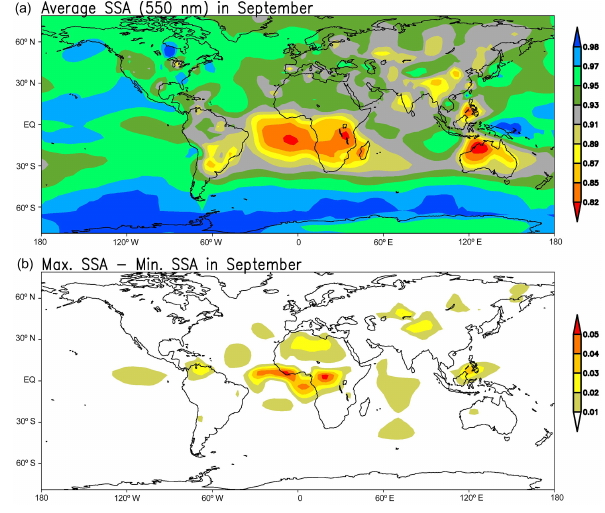
Figure 2. Integration of simulated SSA and AERONET SSA. (a) Average SSA. (b) Maximum SSA – minimum SSA.